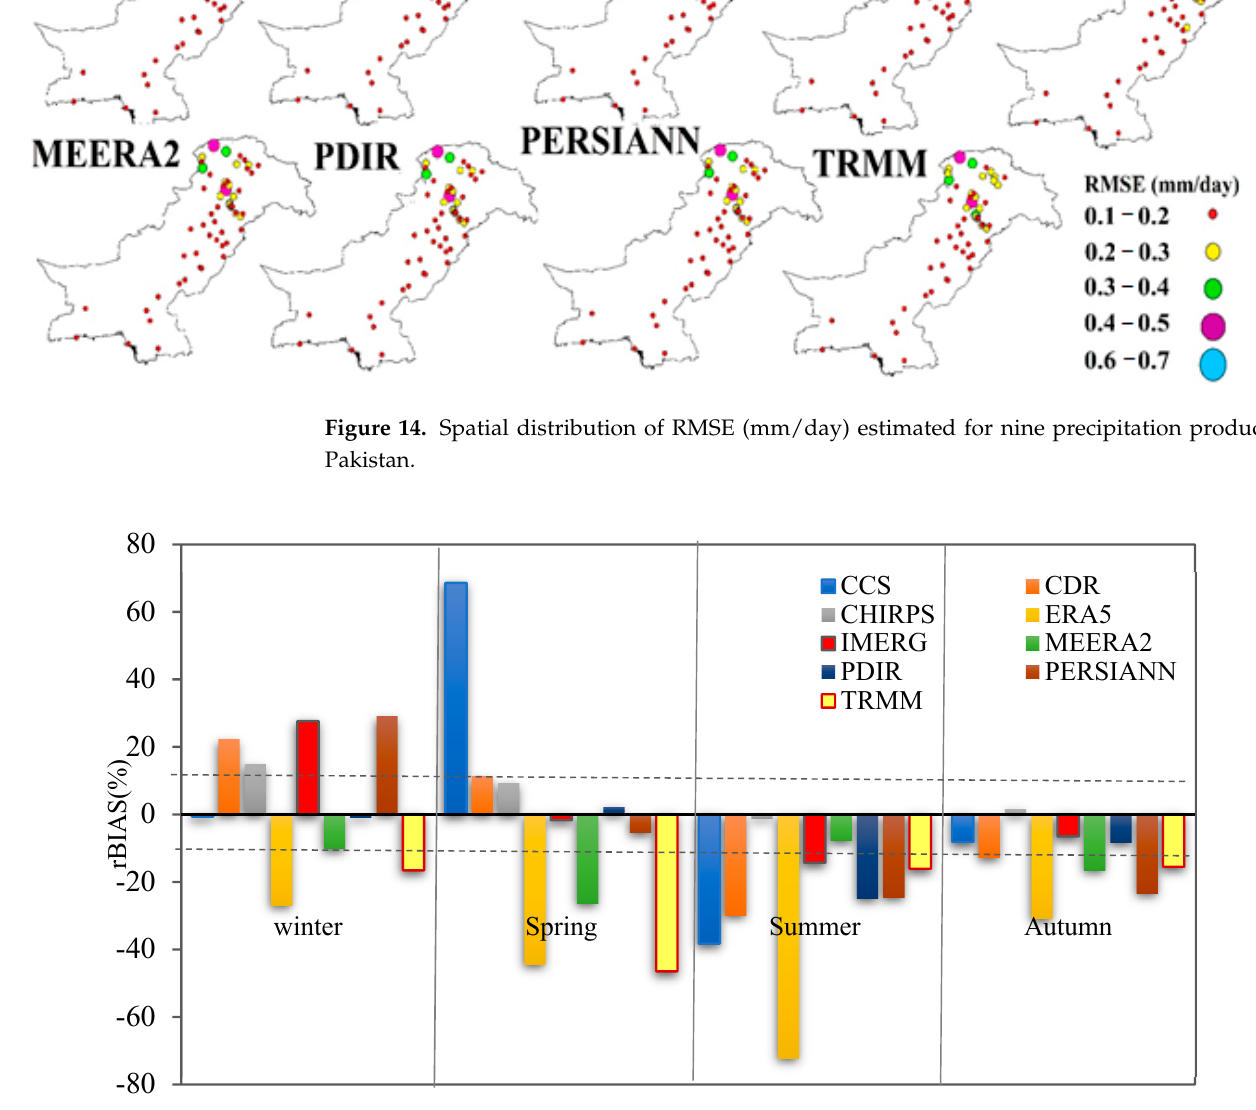
Figure 15. Seasonal variability in the calculated values of rBias (%) for SPPs and reanalysis products in